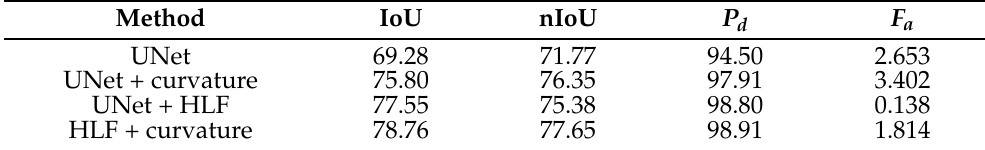
Table 2. Ablation study of different innovation components for the IoU (%), nIoU (%), P d (%), and F a (10 − 5